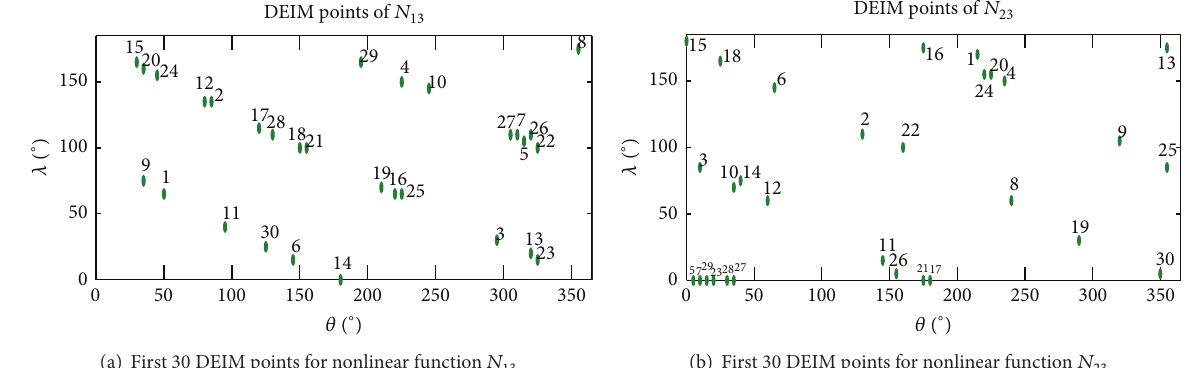
Figure 4: First 30 points selected by DEIM for the nonlinear functions 𝑁 13 and 𝑁 23 .